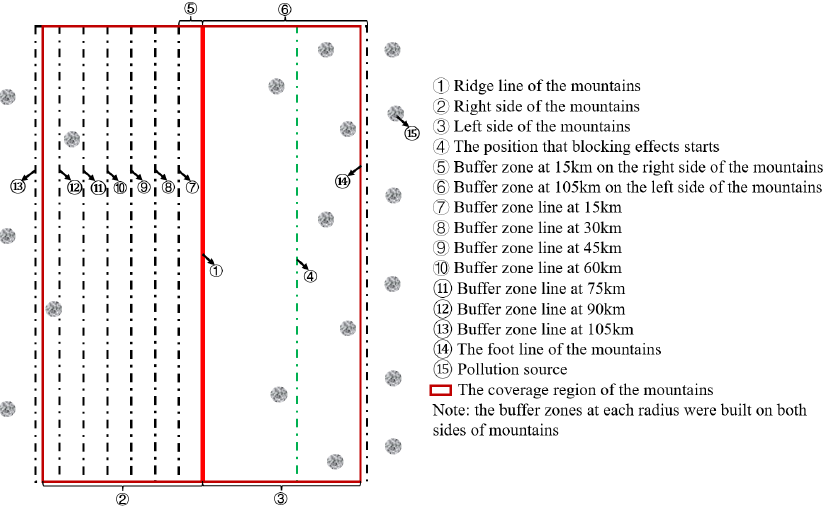
Figure A3. The schematic diagram for the mountains’ coverage, ridge line, the buffer zones and the pollution sources. The green dotted line is the line of the position at which the mountains’ blocking effects on PM 2.5 pollution begin. More information is provided in the above picture.